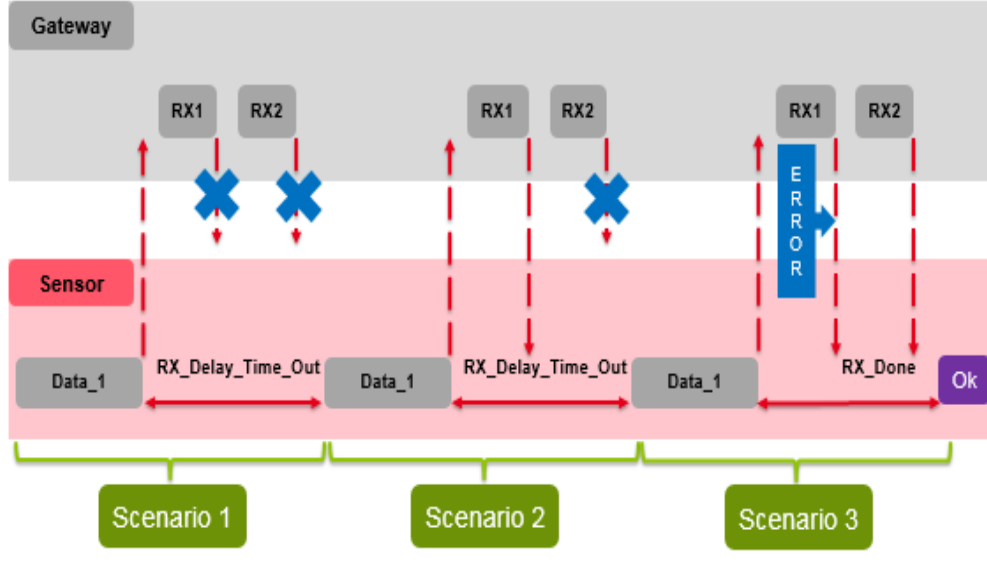
Figure 14. Proposed LoRaWAN (Class A)